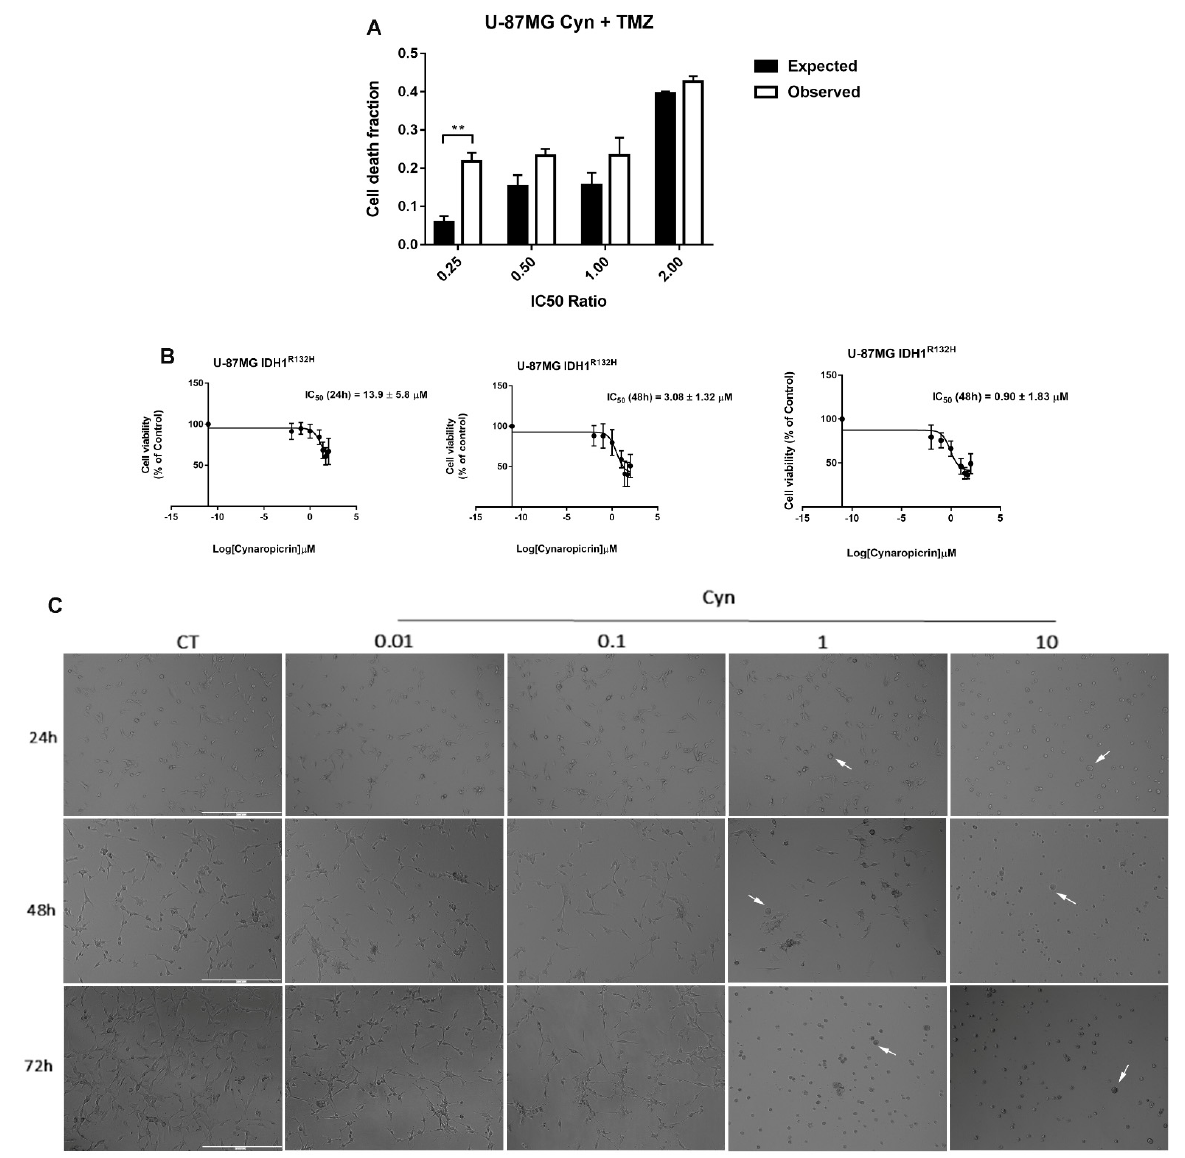
Figure 7. Combined effects of Cyn and TMZ. ( A ) Bliss additivity model to test the combined effects between Cyn and TMZ, using concentration ratios of 0.25 × , 0.5 × , 1 × and 2 × their IC50. Data are expressed as expected versus observed cell death fractions. Unpaired t -test, p -value < 0.05. According to GraphPad Prism 7 software,** p -value 0.001–0.01 (very significant). ( B ) Determination of IC50 values on IDH1 R132H U-87 MG cells using GraphPad Prism 7 software after 24, 48 and 72 h of incubation with Cyn 0.01, 0.1, 1, 10, 25, 50 and 100 µ M and DMSO 0.1% as the vehicle control. ( C ) Morphological change of Cyn-treated IDH1 R132H U-87 MG cells for 24, 48 and 72 h. Cyn 1 µ M dramatically induced a cell morphological change already visible after 24 h of exposure, since cells retracting their cell protrusions become round-shaped (white arrows). Magnification 10 × . Although it has been reported that patients with an IDH mutant glioblastoma and methylated MGMT gene promoter had longer survival than patients with IDH wild-type glioblastoma and an unmethylated MGMT gene promoter [19]; their prognosis remains poor. The IDH1 R132H is among the most common mutations in glioma that serves tested at the ATCC for neomorphic activity of the mutant IDH1 R132H enzyme, and it displayed elevated levels of intra- and extracellular D-2-hydroxyglutarate